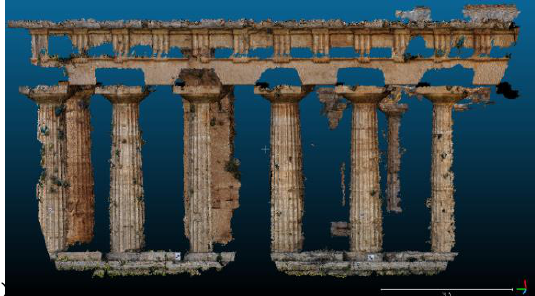
b) Figure 8: Dense 3D reconstruction of part of the temple without semantic masking (a) versus dense 3D reconstruction with semantic masking and exclusion of the sky category (b).